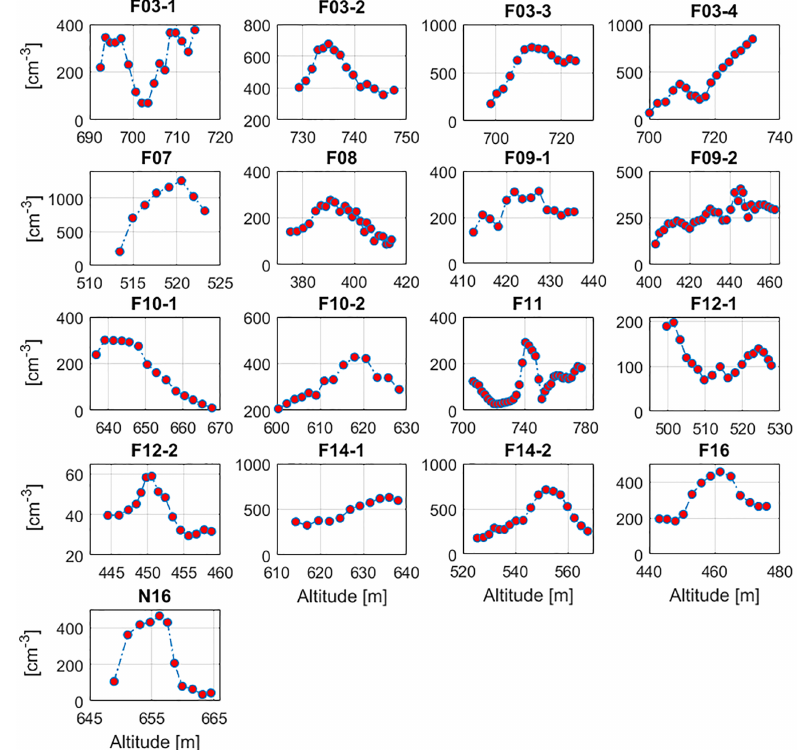
Figure 7. Same as Fig. 5 but for particle concentration in diameter range 3–10nm (UFCPC-CPC).